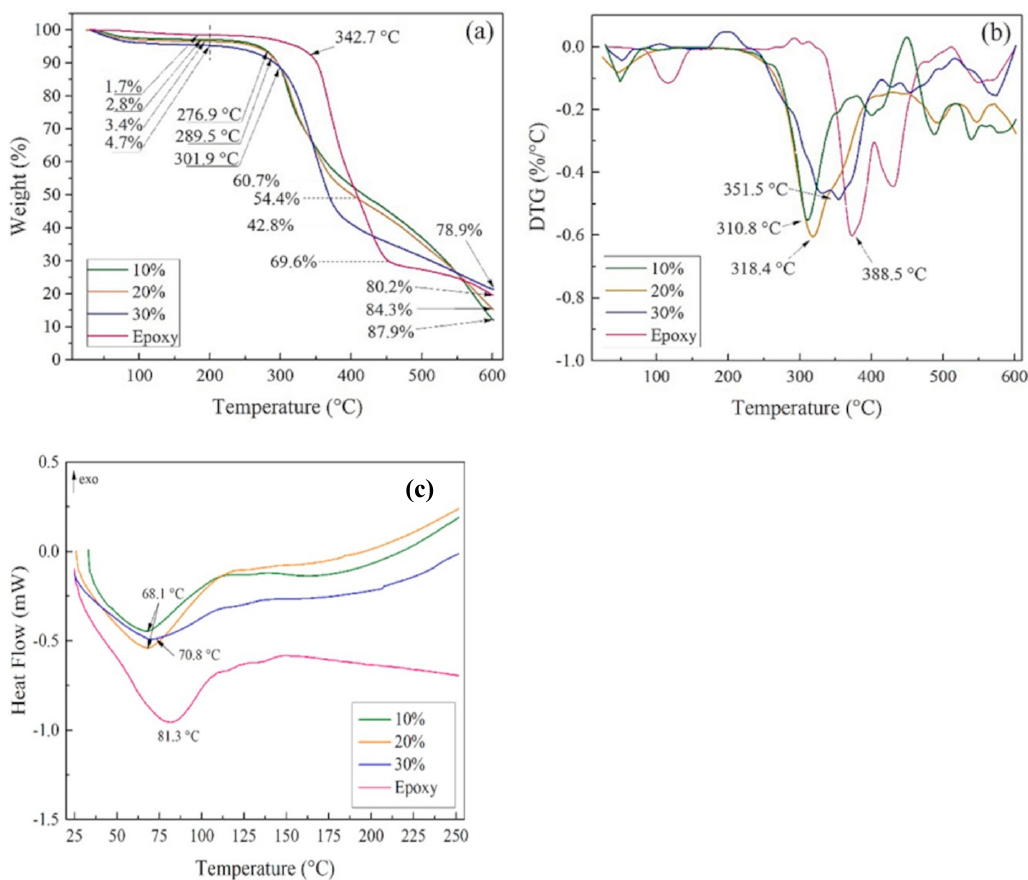
Figure 8. TGA ( a ), DTG ( b ), and DSC ( c ) curves of epoxy resin and epoxy/hemp fiber composites [159]. (Reprinted/adapted with permission from Elsevier Ref.5457220890548 Copyright